Question: Briefly state, in one sentence, what is plotted here.
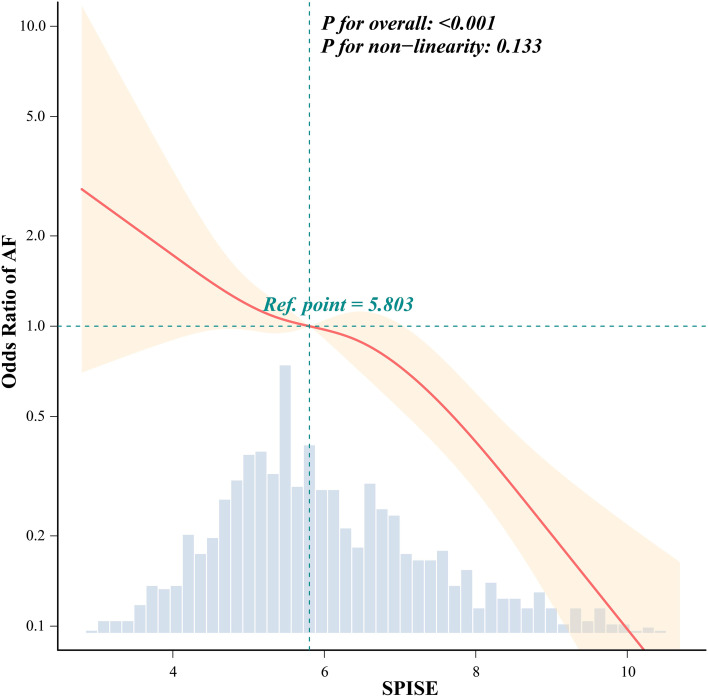
Answer: Restricted cubic spline analysis of the association between SPISE and atrial fibrillation. The spline model used four knots, and odds ratios were presented using SPISE = 5.803 as the reference value. The shaded area represents the 95% confidence interval.